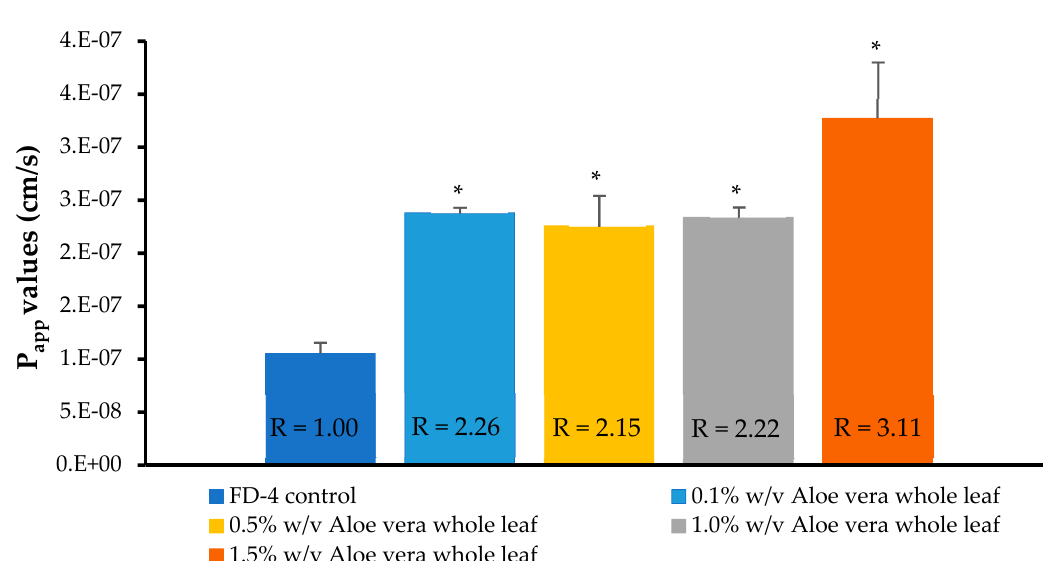
Figure 7. Apparent permeability coefficient (P app ) values of the FITC-dextran (FD-4 with MW of 4 kDa)